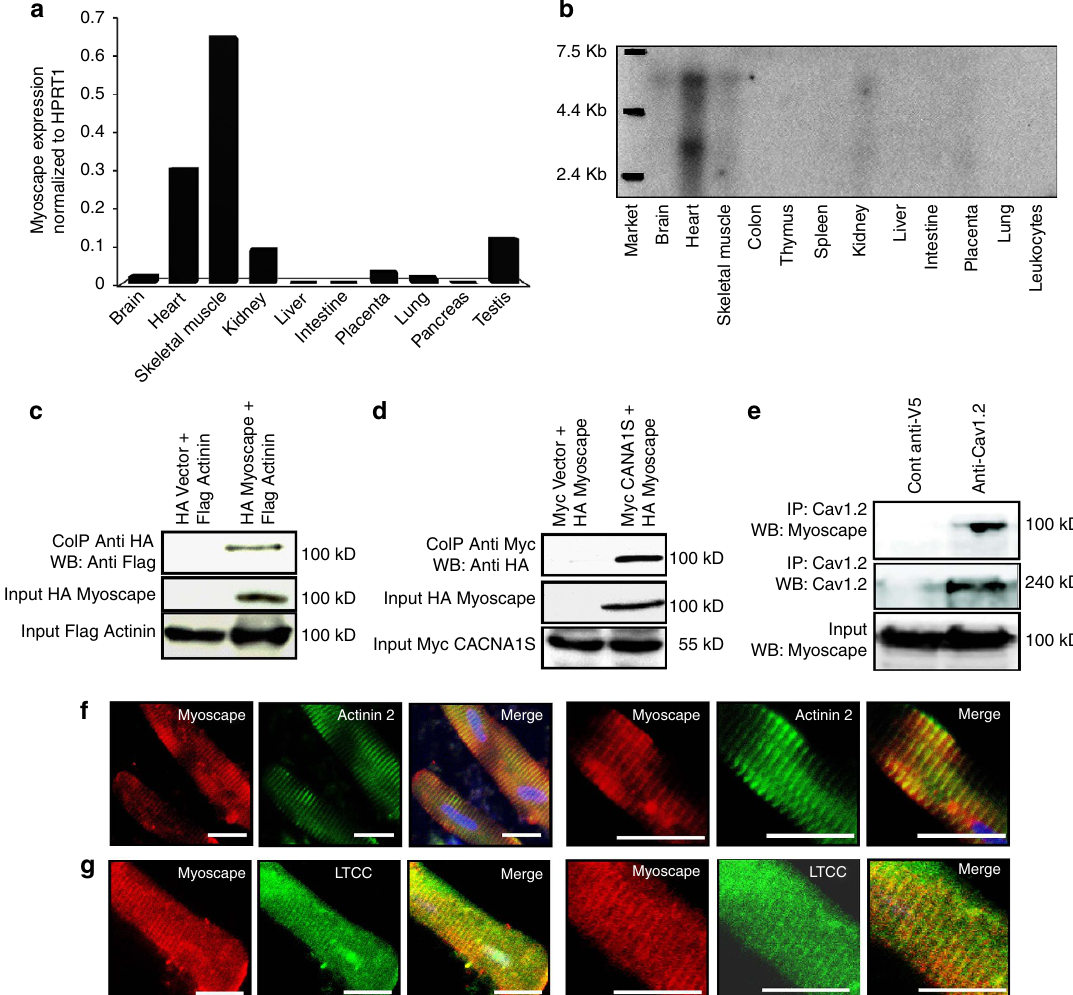
Figure 1 | Myoscape expression profile and subcellular localization. ( a ) Mouse muscle and heart Myoscape mRNA expression profile confirmed by HPRT1-normalized quantitative qPCR and ( b ) additional Northern blot analyses of multiple human tissues using Myoscape-specific probes and primers. Confirmation of the interaction between a -actinin 2 ( c ) and the skeletal muscle-specific pore-forming unit ( d ) of the LTCC (CACNA 1S) with myc-tagged Myoscape by co-immunoprecipitation of the proteins in HEK-T cells. ( e ) Immunoprecipitation performed with endogenous proteins isolated from mouse heart using anti-V5 (control) or anti-Cav1.2 antibody followed by immunoblotting performed with Myoscape antibody, indicates the physiological interaction between Cav1.2 and Myoscape. ( f – g ) Confocal Immunofluorescence analysis of Myoscape expression in isolated adult rat ventricular myocytes shows a striated signal. Myoscape is localized to couplons near the sarcomeric z-band/t-tubule interface, as evidenced by coimmunostaining of Myoscape and actinin 2 and LTCC and RYR2. Scale bars, 20 m